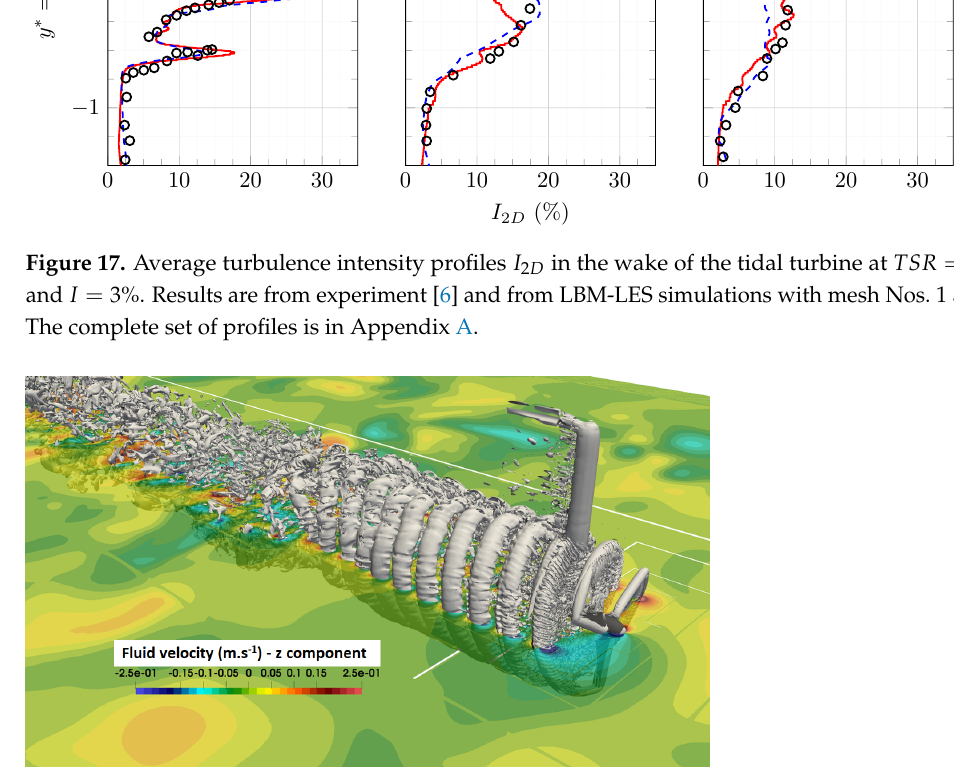
Figure 18. Three-dimensional view of the turbine with an upstream turbulence rate of I = 3%, instantaneous U z velocity. Tip-vortices are observable with iso-contour of the lambda 2 criterion. LBM-LES simulation with mesh No.